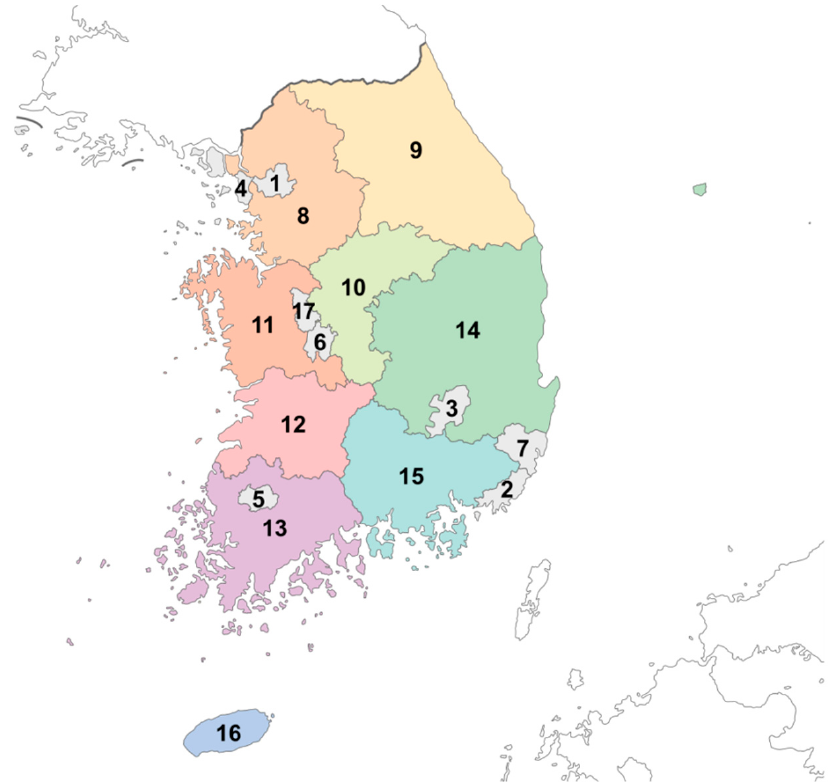
Figure 3. Map of 17 local governments in South Korea.